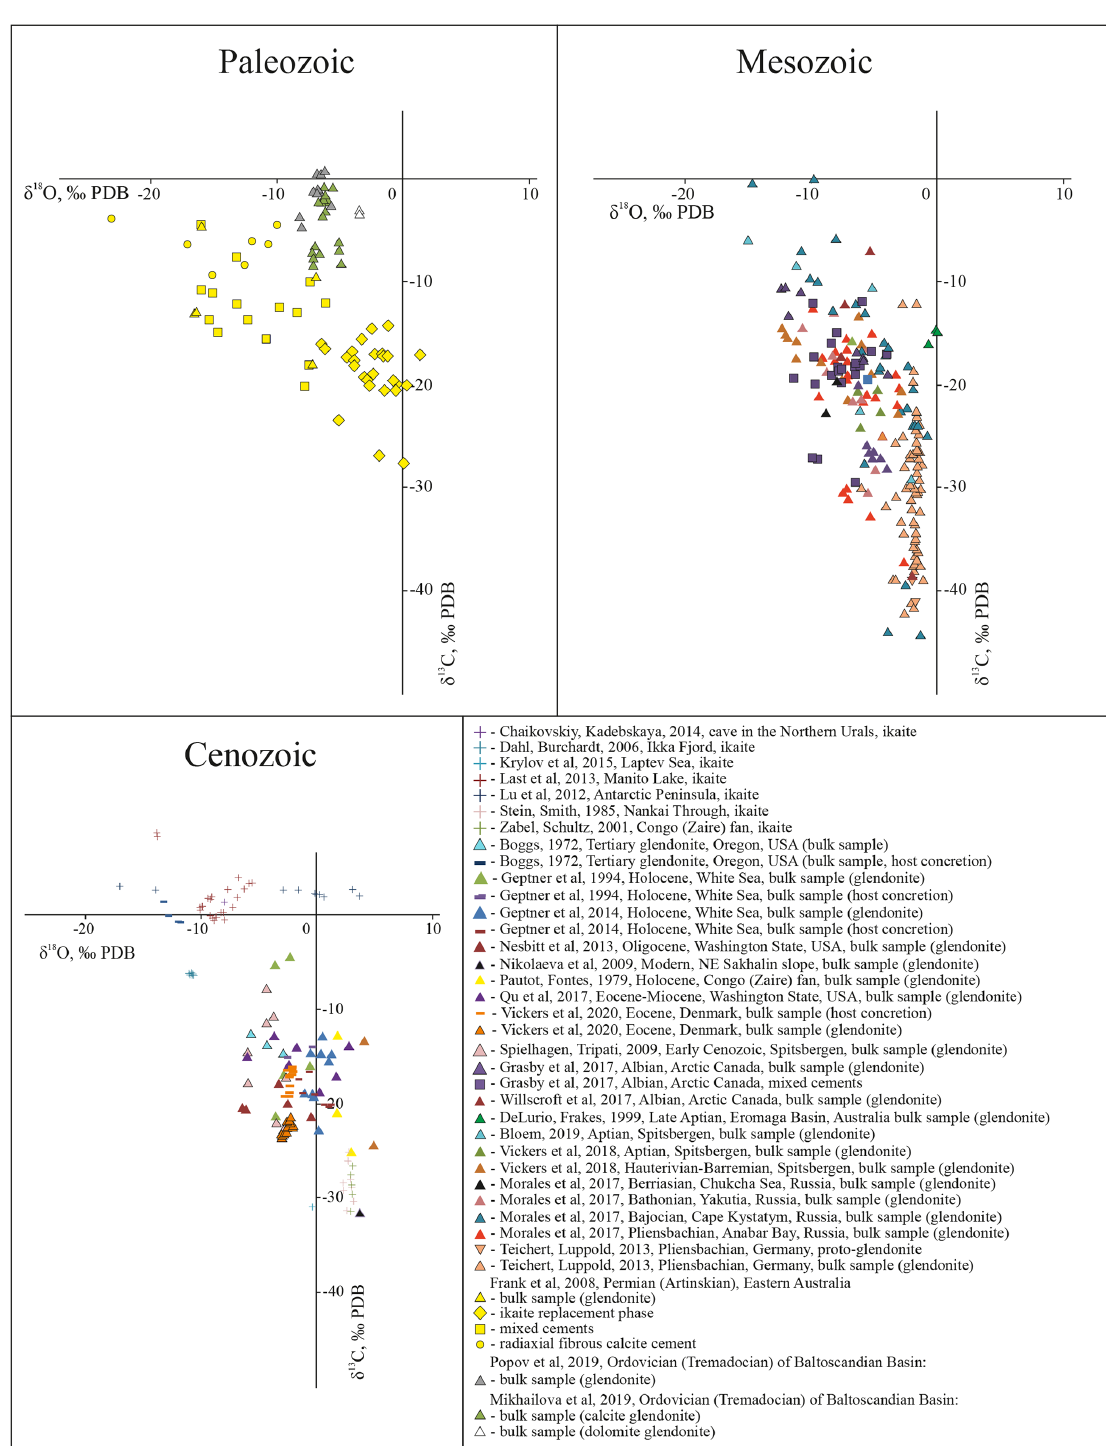
Figure 3. Isotopic composition of glendonites (including different generations), host concretions, and ikaites for Paleozoic, Mesozoic, and Cenozoic